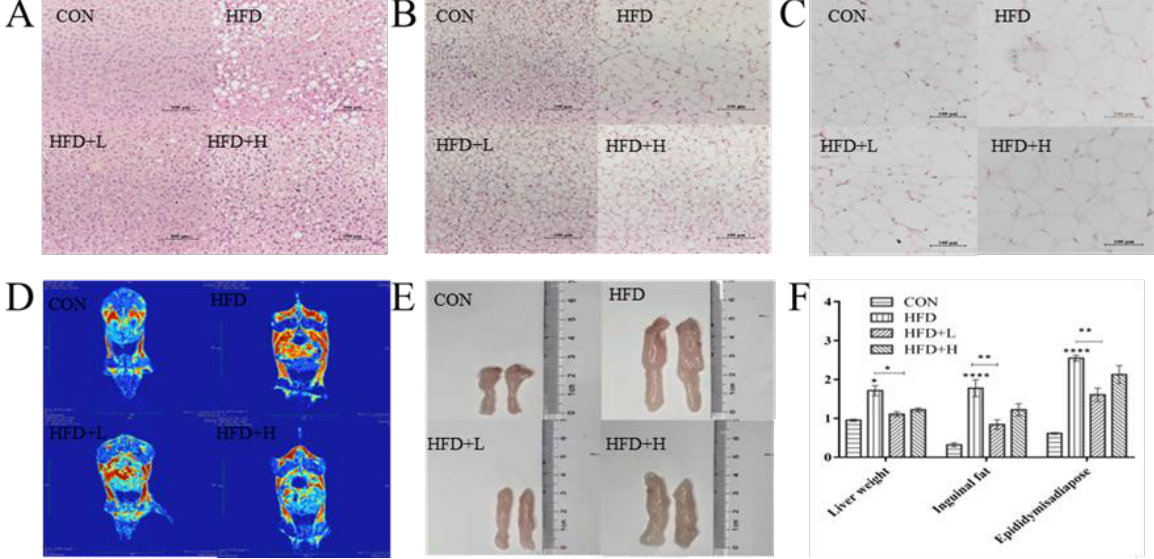
Figure 3. CIP prevented fat mass accumulation in HFD-fed mice. ( A ) H&E staining of liver, ( B ) H&E staining of brown fat and groin fat, and ( C ) of mice in CON, HFD, HFD+L, and HFD+H (scale bar, 100 μm) ; ( D ) quantitative magnetic resonance was performed for the analysis of body composition; ( E ) length of groin fat; ( F ) the organs weight of mice ( n = 7). Data were shown as mean ± SEM. * p < 0.05, ** p < 0.005 and **** p < 0.0001 compared with the other groups.